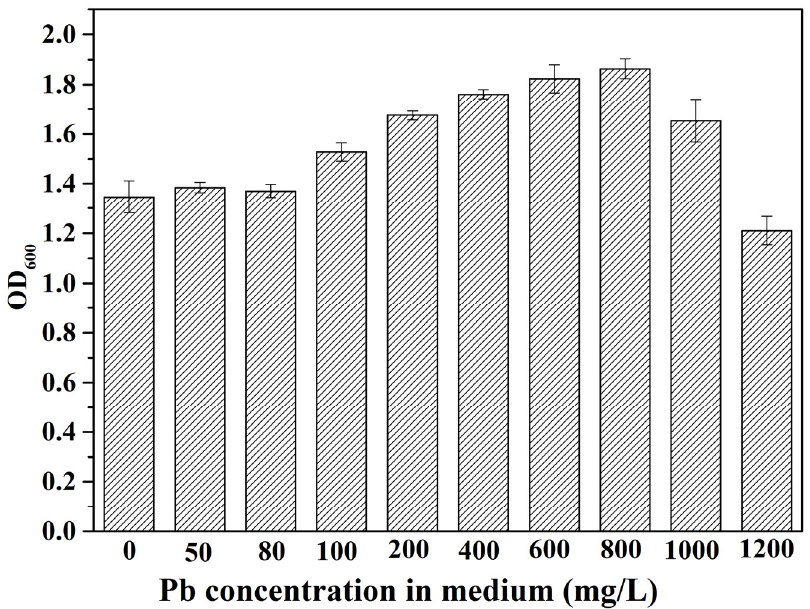
Figure 10. OD 600 values for bacteria in media having different Pb concentrations (24 h).